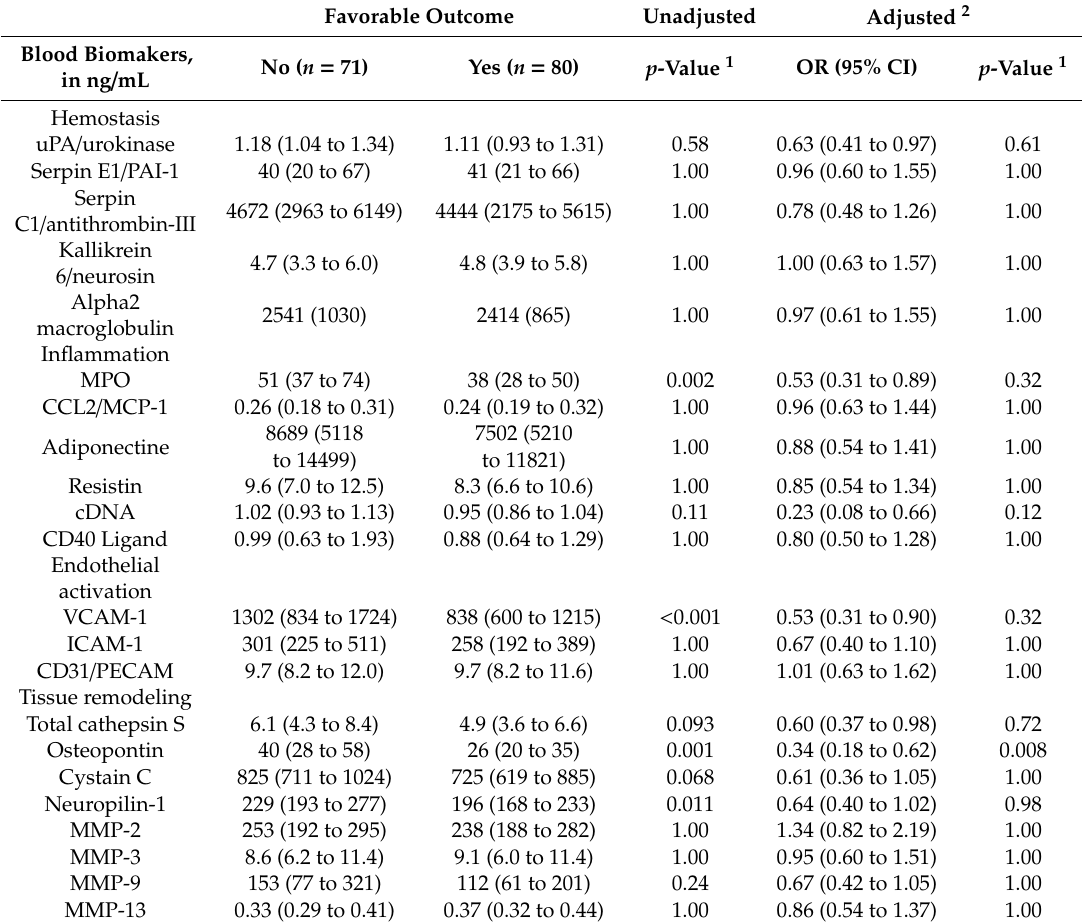
Table 2. Associations of biological markers with a favorable outcome. Favorable Outcome